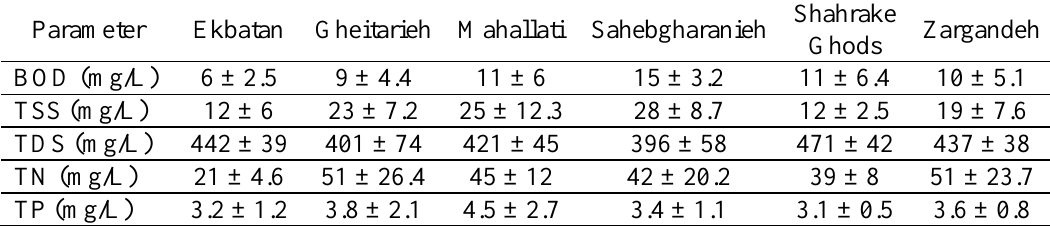
Shahrake Zargandeh Ghods